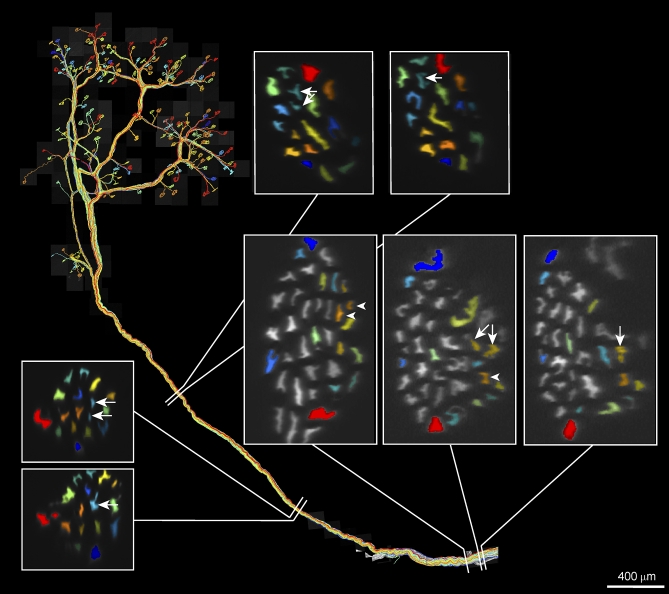
Extramuscular Branching of Motor Axons Projecting to the Interscutularis MuscleAll axons innervating sample M4R were reconstructed and color-coded according to their motor unit sizes (see Figure 3). Axons shown in grey projected to other muscles and did not innervate the interscutularis muscle. White boxes show the nerve's cross section just before and just after each of the four instances of axonal bifurcation (arrows and arrowheads show the branching axon).